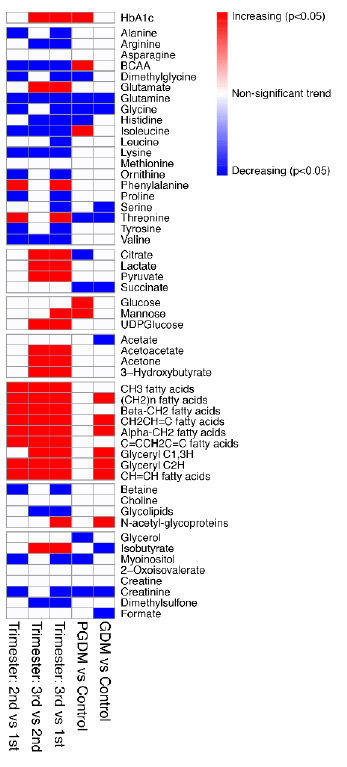
Figure 1. Partial least squares discriminant analysis (PLS-DA) reveals separation of maternal serum specimens from women across gestation. ( A ) The PLS-DA scores plot reveals separation of first- ( n = 75; red), second- ( n = 42; green), and third-trimester ( n = 104; blue) serum specimens. ( B ) Variable importance of projection (VIP) plot for the first 15 metabolites that contribute to separation in PLS-DA component 1. A higher VIP score indicates a greater contribution of that metabolite to the separation of the groups.